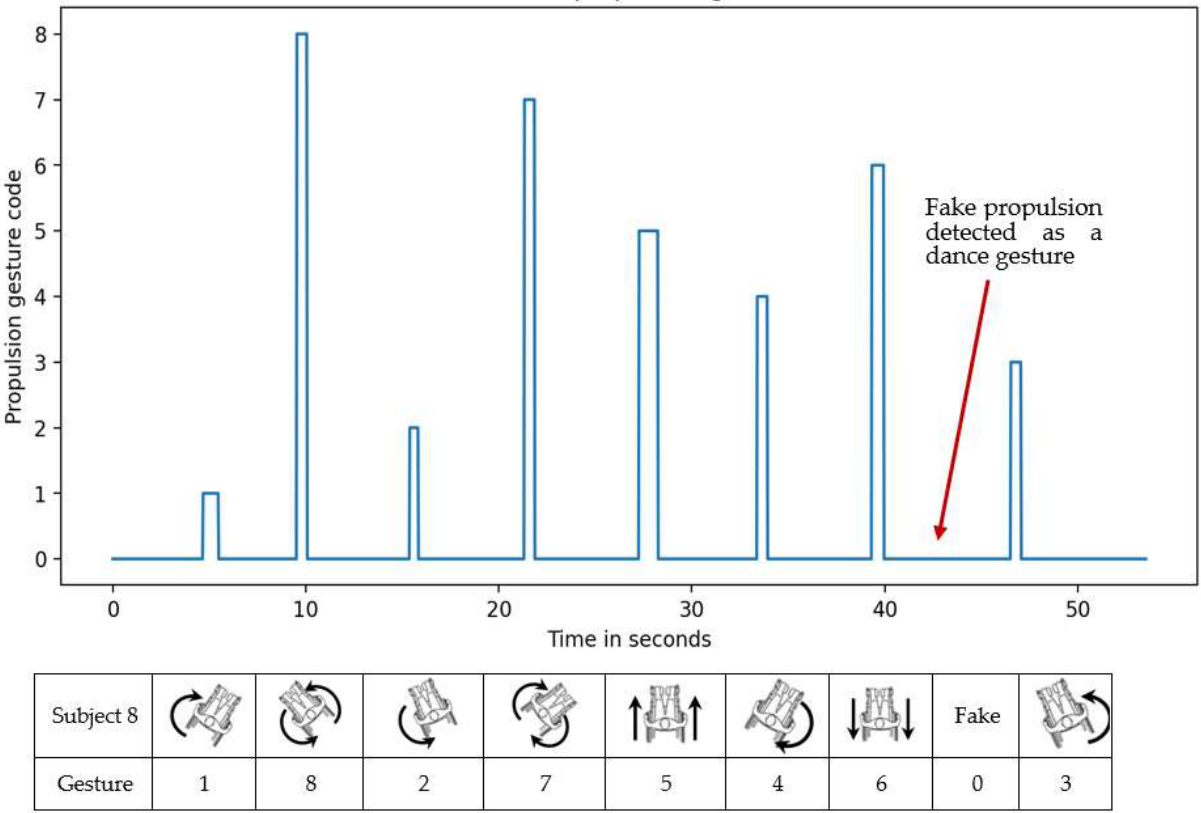
Figure 16. Actual choreography and prediction comparison.